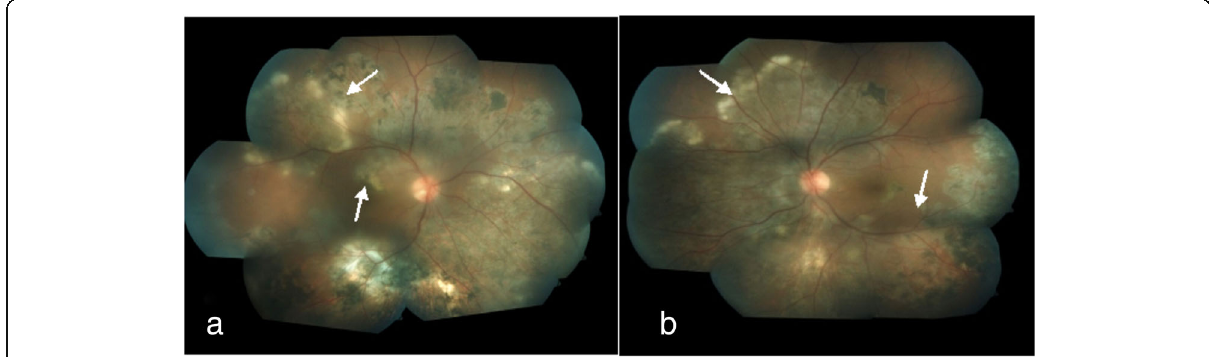
Fig. 3 a , b Fundus photograph of both eyes at 12 weeks showing resolution of the lesions with scarring over fovea in the right